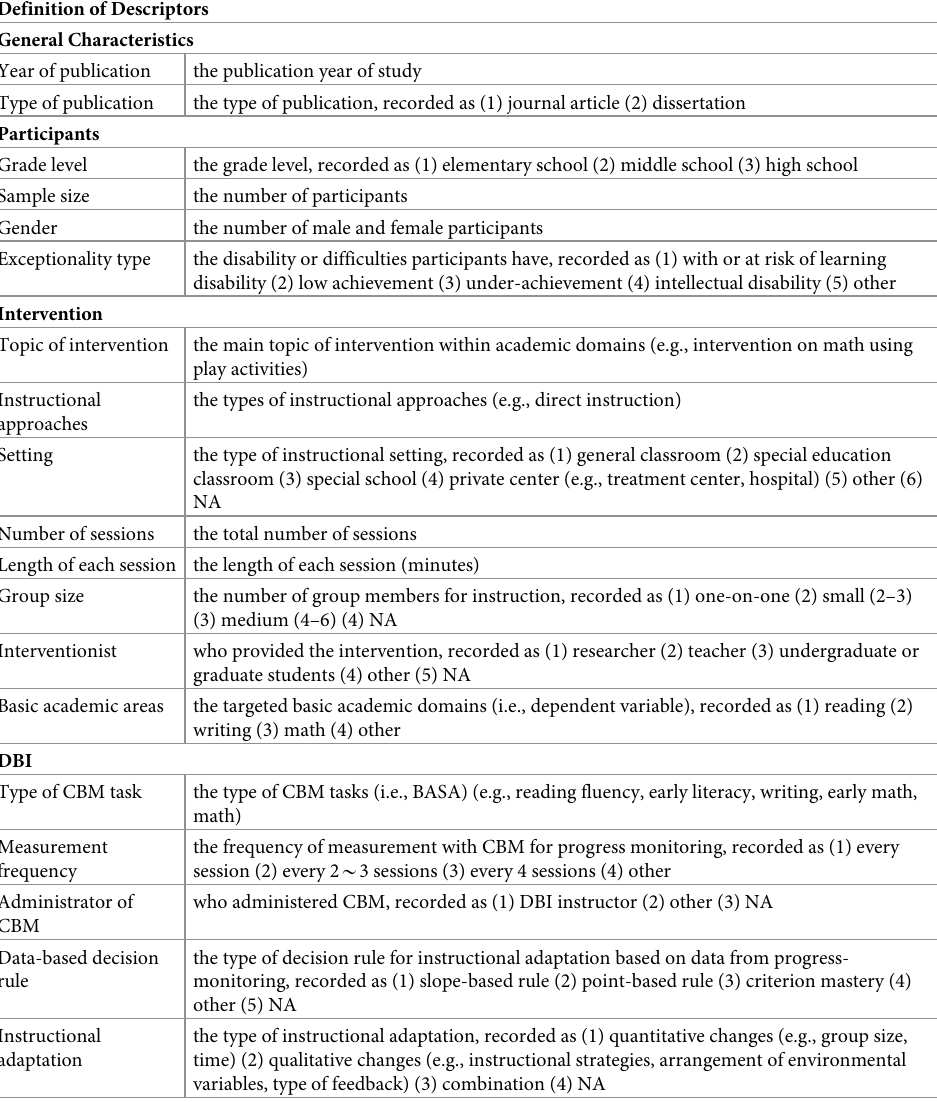
Table 1. Coding system for